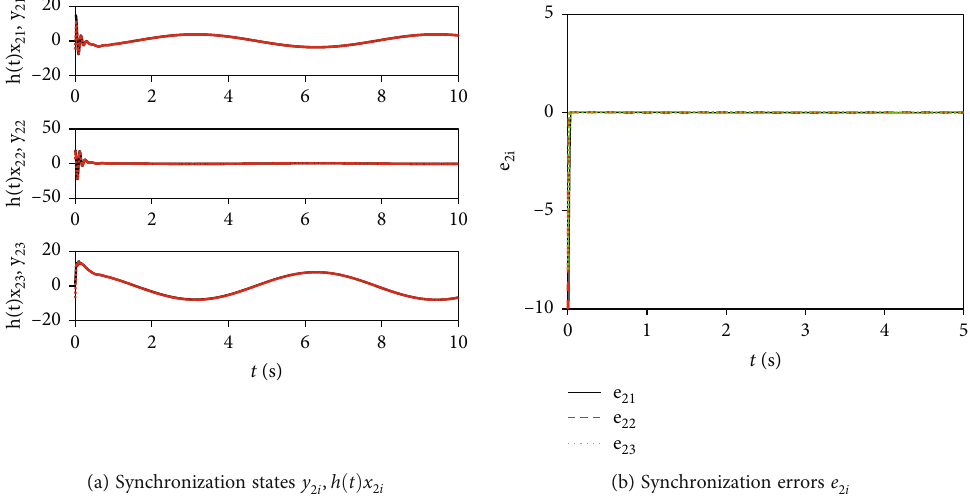
Figure 4: The time evolution of synchronization between y